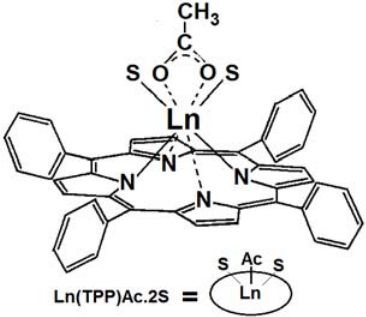
Figure 9. Structure of lanthanide acetate-tetraphenylporphyrins, Ln(TPP)Ac·2S (where Ln = Lu, Yb, Tm, Er, Ho, and S =